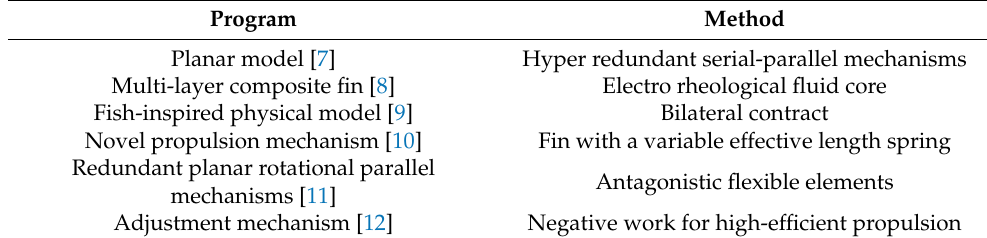
Table 1. Some studies on changing the stiffness of robotic